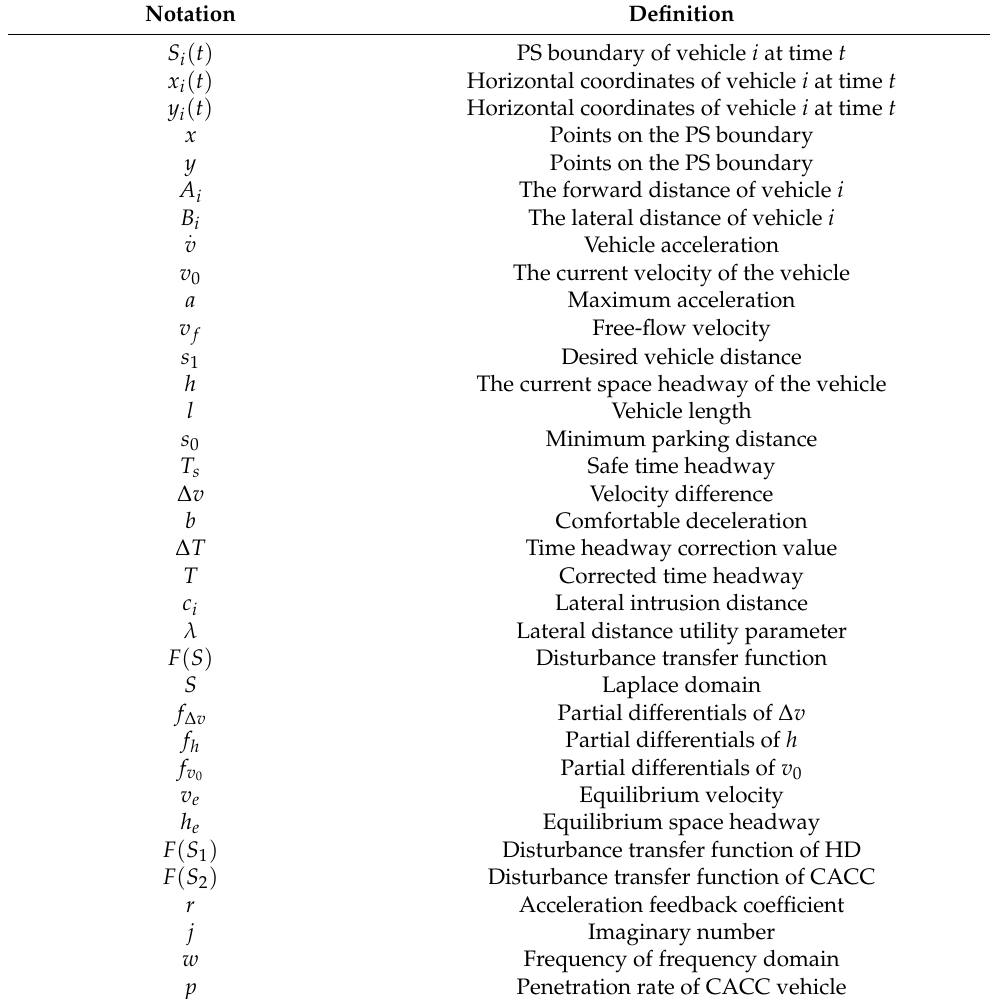
Table 2. Notations Summary